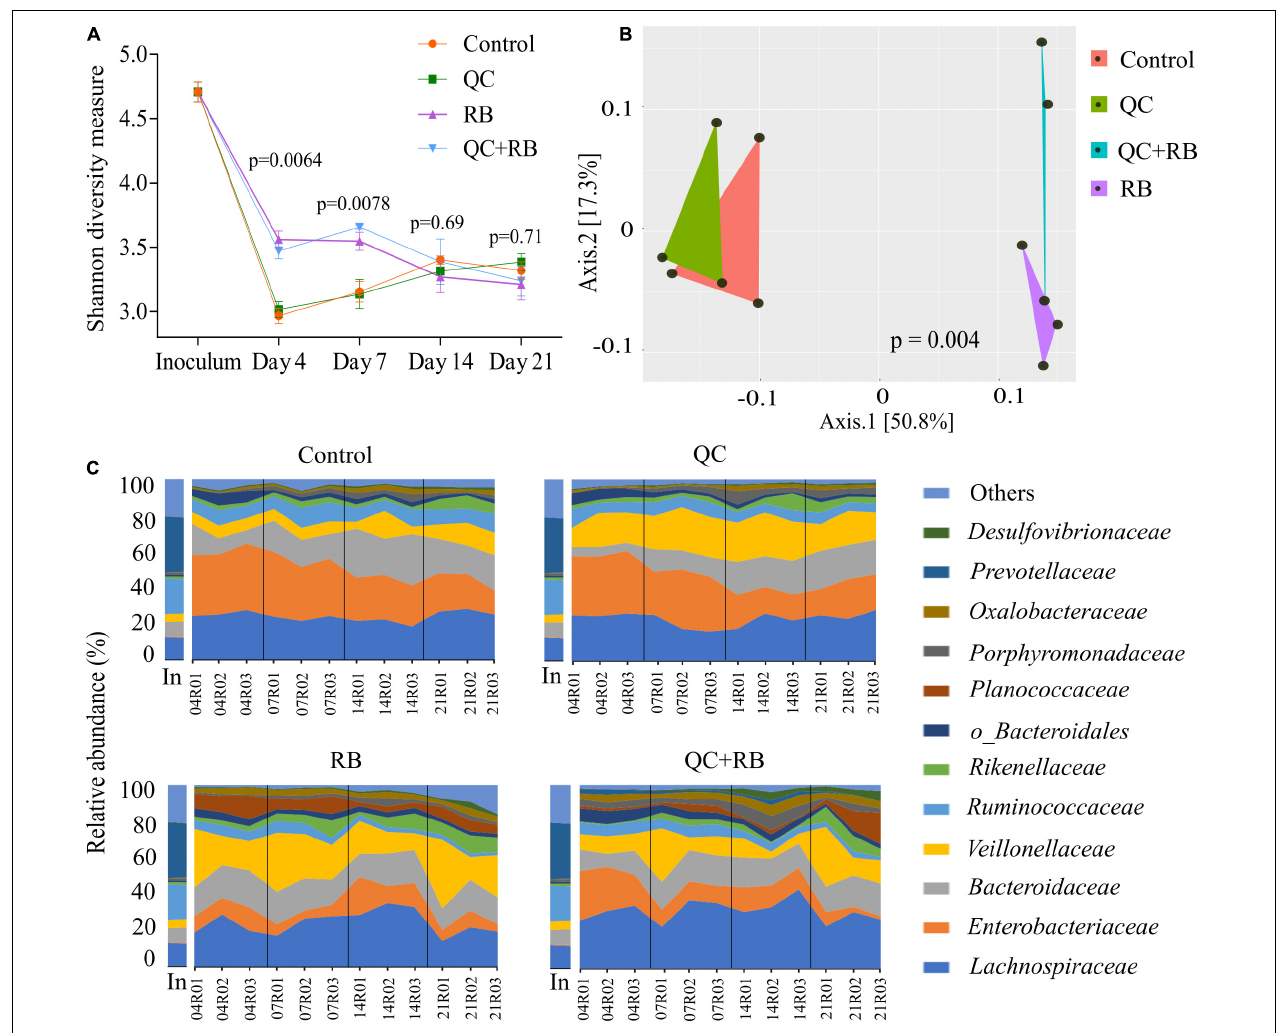
FIGURE 2 | Gut microbiota compositional changes following quercetin and rice bran supplementation (A) Alpha diversity of four groups (control, QC, RB, and QC + RB) at day 4, 7, 14, and 21 from amplicon sequencing data. (B) Beta diversity among the control, QC, RB and QC + RB groups were obtained using shotgun metagenome sequence analysis on day 21. “MDS” ordination followed by Bray-Curtis dissimilarity calculation was used to visualize the differences between the groups (adonis, p = 0.004). (C) Temporal family-level composition of the most abundant 12 bacterial taxa at day 4, 7, 14, and 21 and inoculum determined using 16S rRNA community profiling for Control, QC, RB, and QC + RB